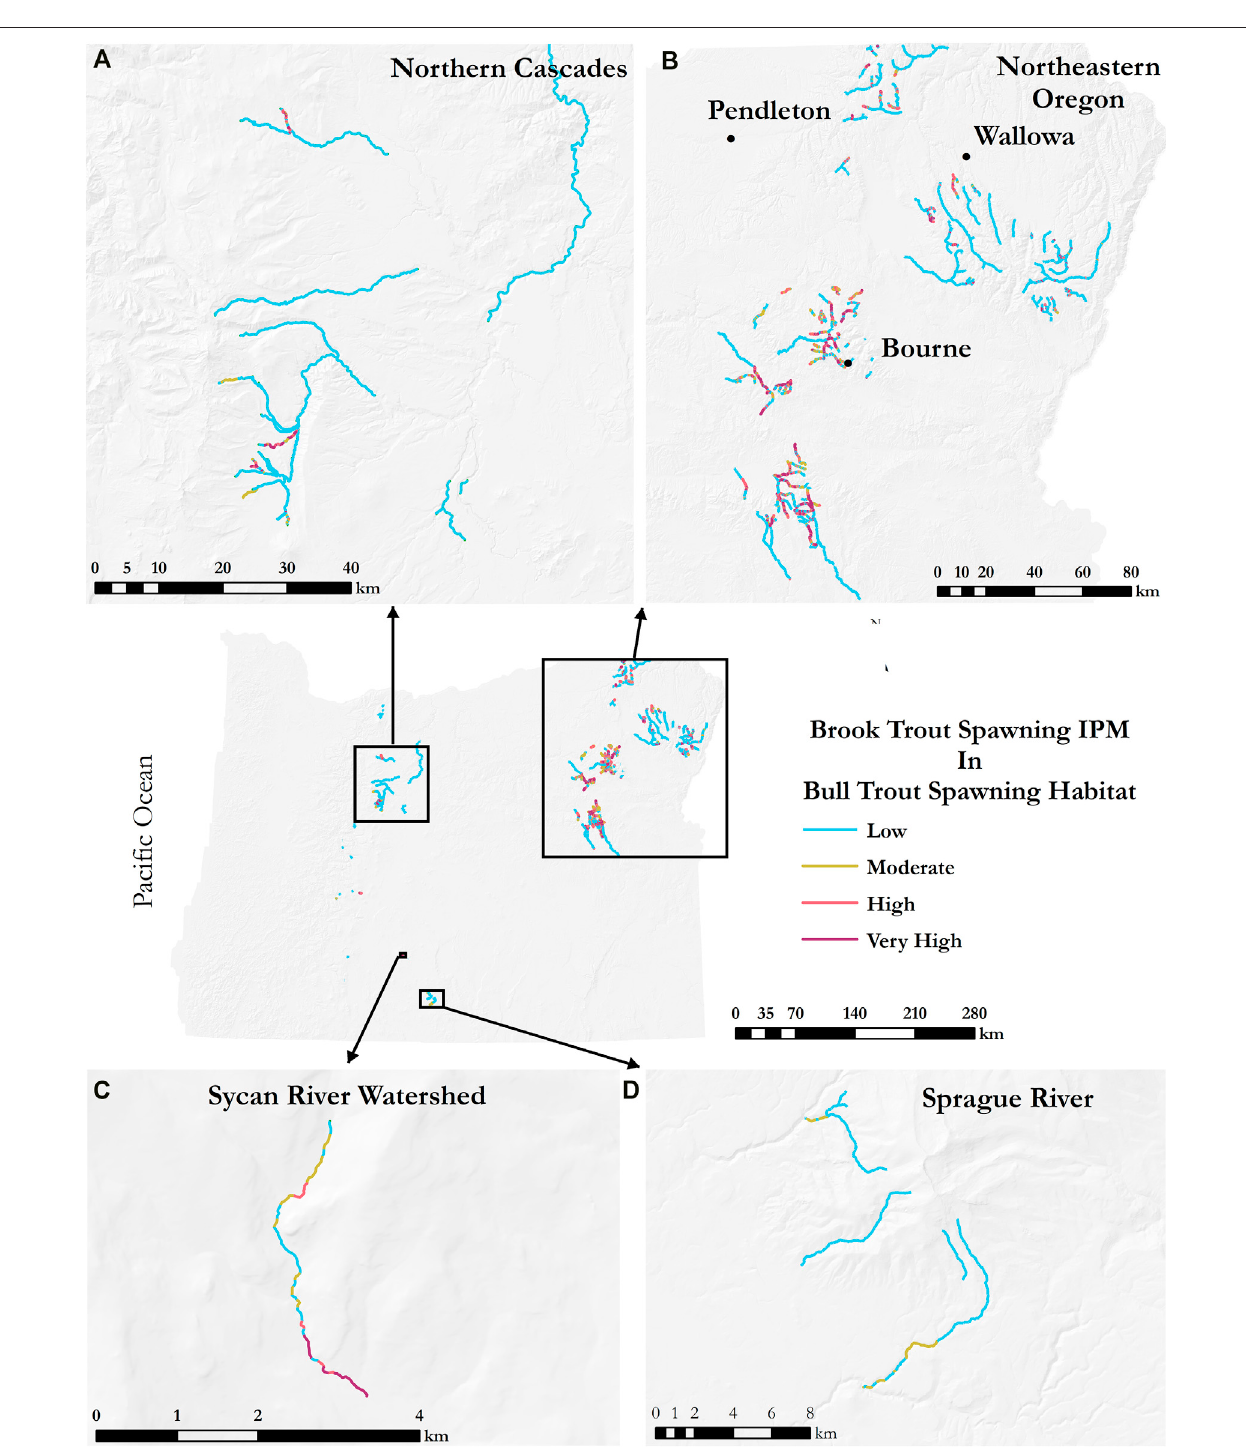
FIGURE 6 | Overlap of brook trout spawning intrinsic potential in bull trout spawning habitat. Selected regions in (A) – (D) illustrate major areas of spawning habitat overlap including (A) Northern Cascades, (B) Northeastern Oregon, (C) Sycan River, and (D) Sprague River.